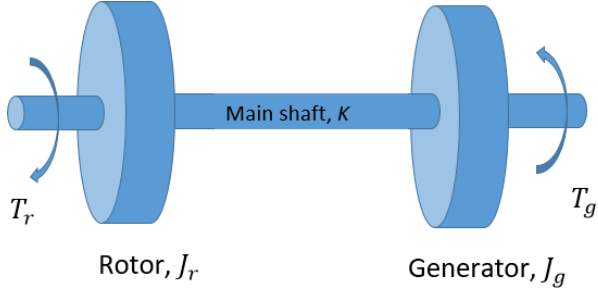
Figure 1. A two mass model of the wind turbine drivetrain.